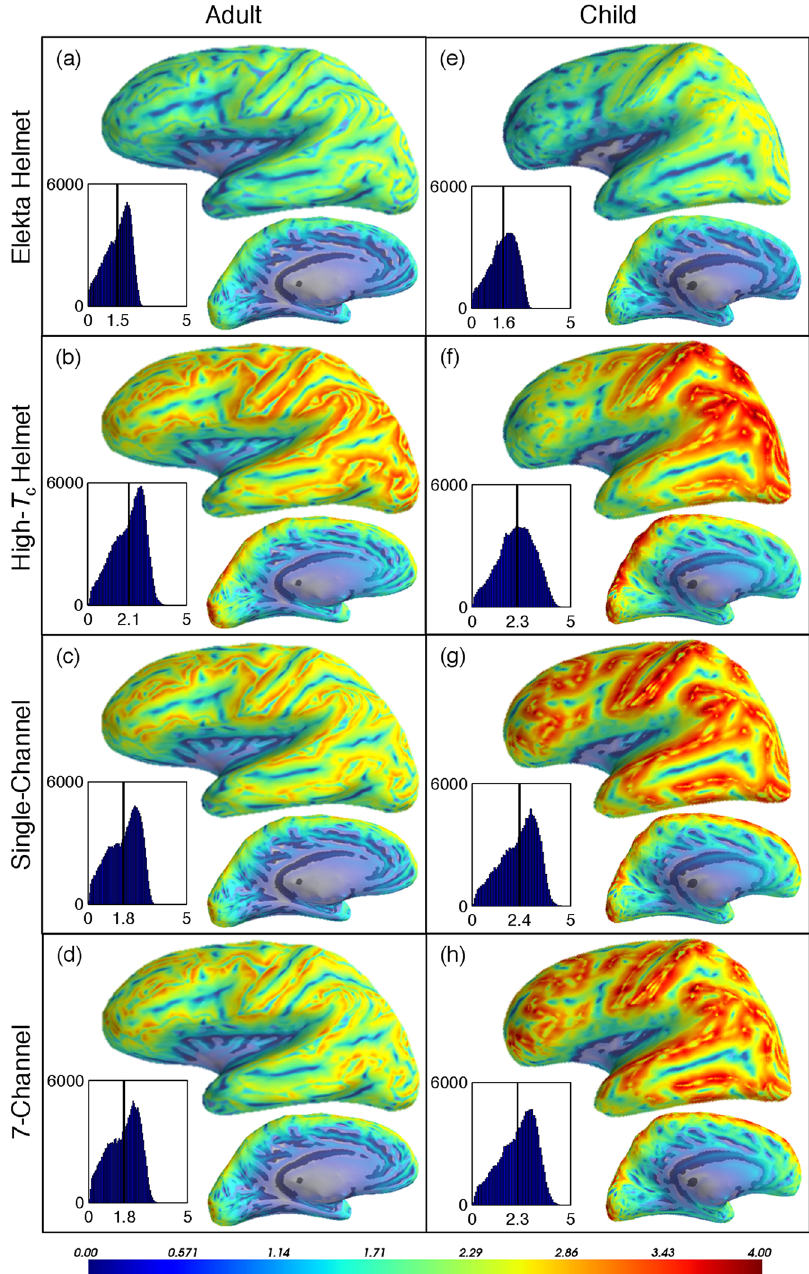
Figure 4. SID-maps for all layouts sampling the adult and child brains (left and right columns, respectively). Each panel displays lateral and medial views of the left hemisphere of the brains; results do not differ significantly for the right hemisphere. We use optimistic noise levels for the on-scalp sensors (10 fT/ √ Hz). Histograms of the distribution of SID values for both hemispheres are included (with a vertical reference line marking SID avg for each layout-subject pair). Coverage is roughly uniform for all on-scalp layouts for both subjects. A weak gradient from the frontal to occipital lobes for the adult brain as sampled with helmet layouts is far more pronounced for the child. Peak and average SID values for the on-scalp layouts recording from the child brain are significantly higher than for the